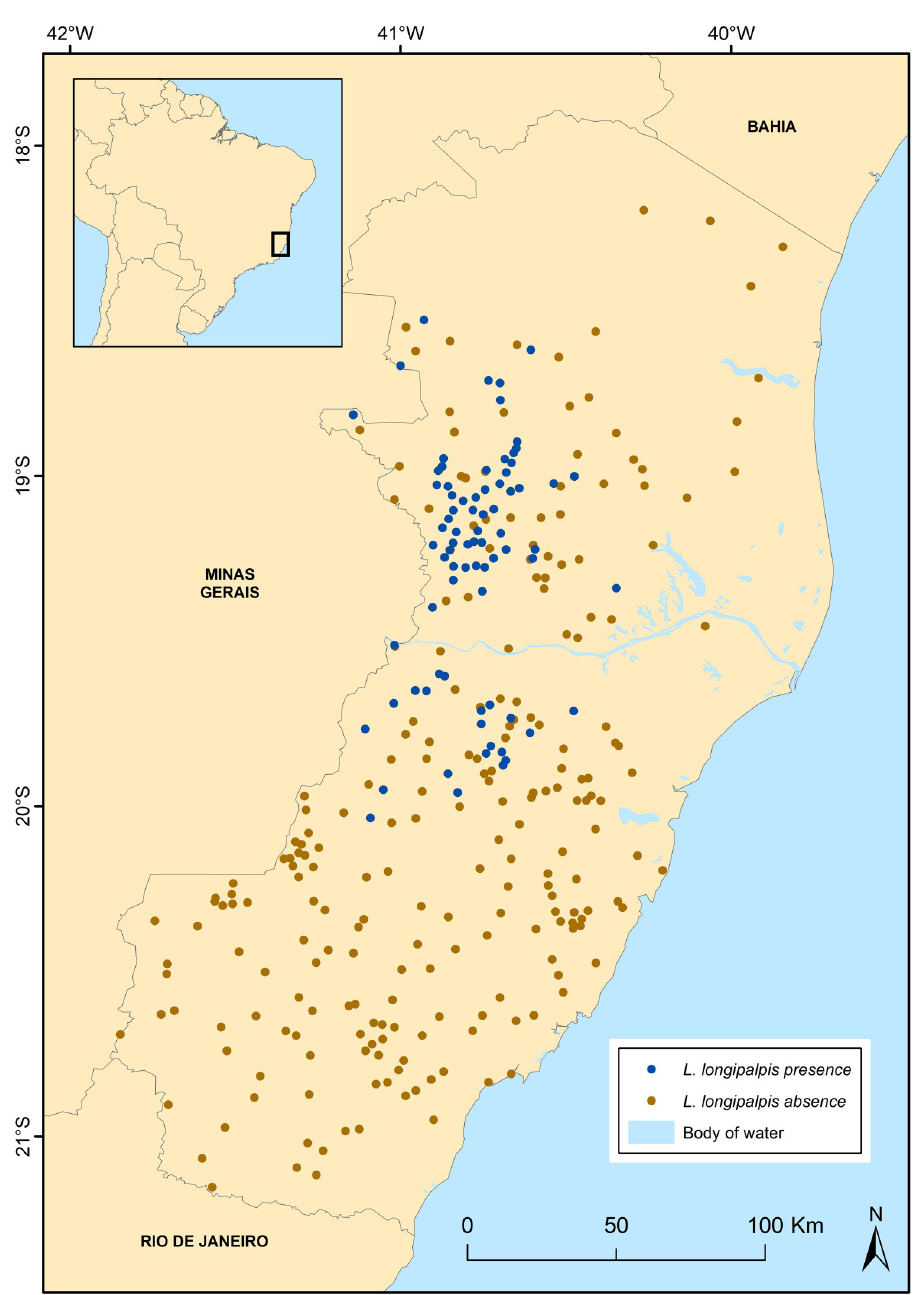
Fig 1. Sampling localities of phlebotomine sand flies in the state of Espı´rito Santo, southeastern Brazil, during the period between 1986 and 2017. Green dots represent the localities where L . longipalpis was collected, and red dots the localities where other phlebotomine species were collected but not L . longipalpis